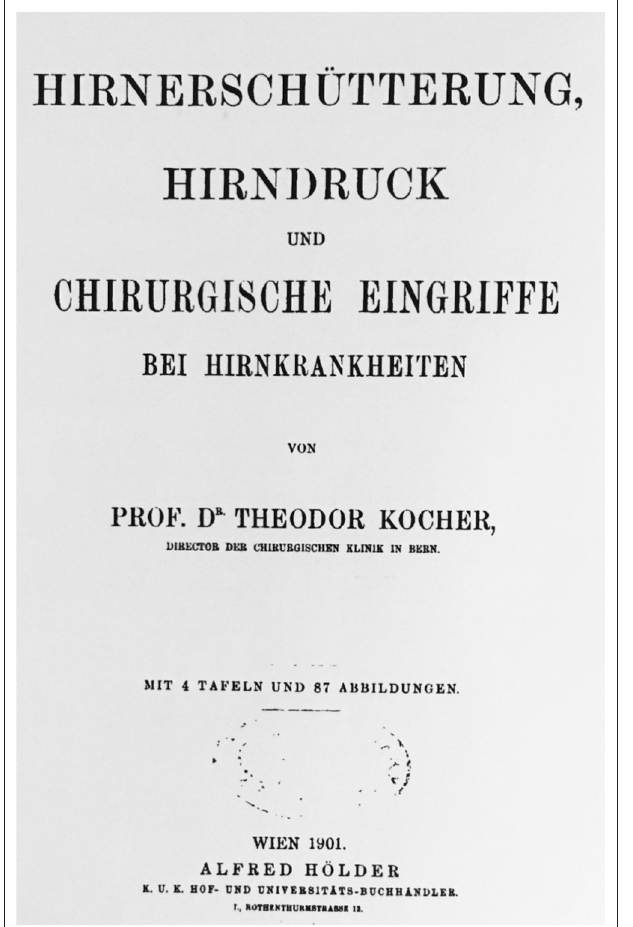
FIGURE 3 | Frontispiece of the manuscript by Dr. Theodor Kocher [from Kocher ( 18). Figure is in public domain and no permission is required for reuse].